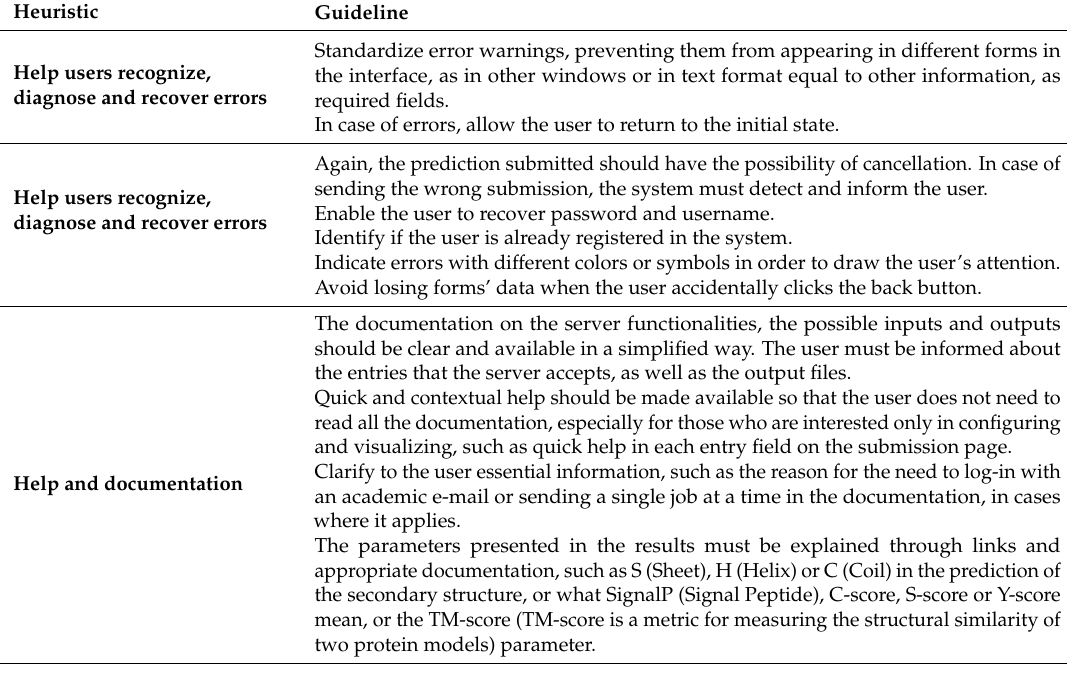
Heuristic Guideline Help users recognize, diagnose and recover errors